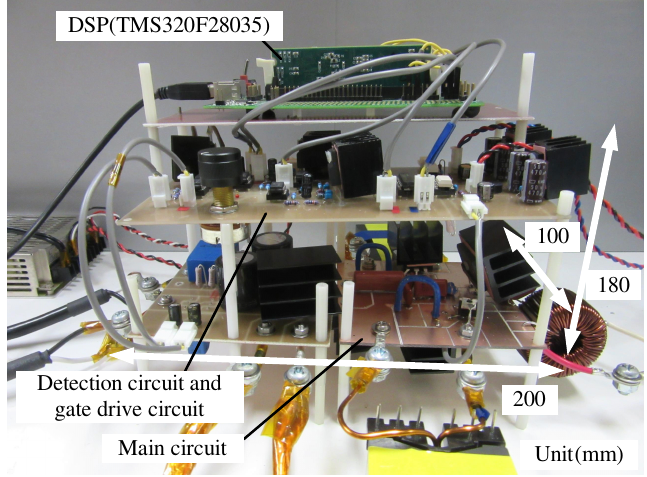
Figure 16. The picture of the LED driver used in an